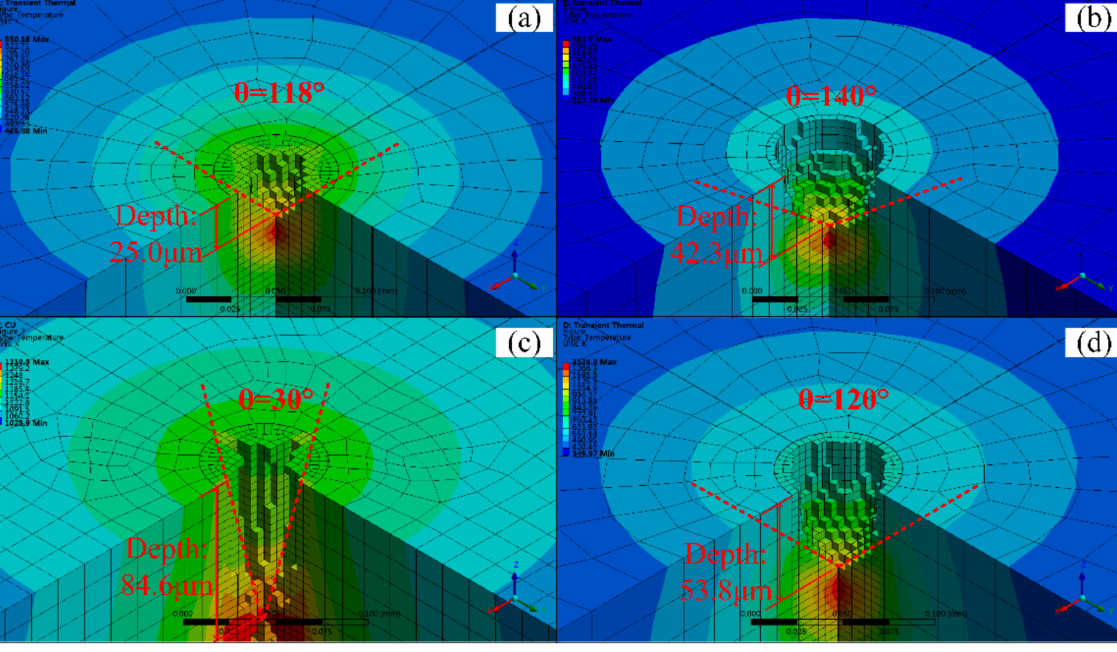
Figure 6. The drilling simulation of hole interior shape: ( a ) aluminum alloy, ( b ) titanium alloy, ( c ) copper, ( d ) stainless